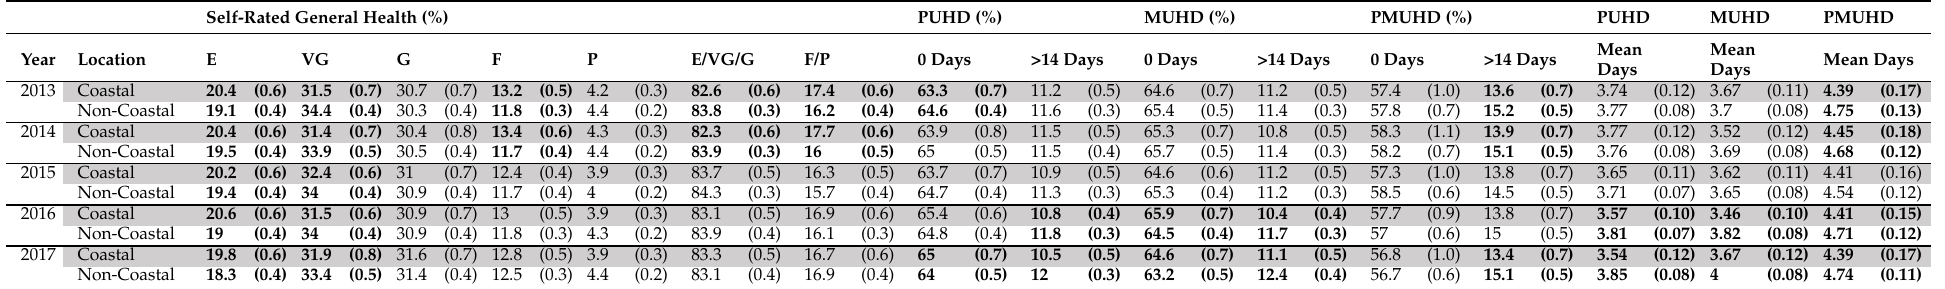
Table 6. Comparison of all non-Gulf coastal vs. all non-Gulf non-coastal MMSAs (all Gulf MMSAs excluded): Mean self-rated general health and unhealthy days. (See table notes for